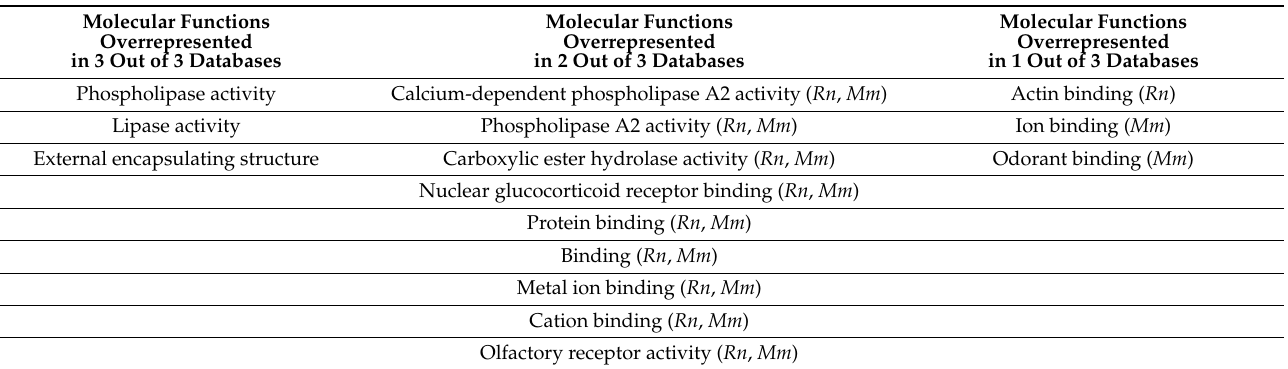
Table 3. Selected GO “molecular function” terms significantly overrepresented solely in Fil050G after 10 days of implantation in the Homo sapiens ( Hs ), Mus musculus ( Mm ), and Rattus norvegi- cus ( Rn )